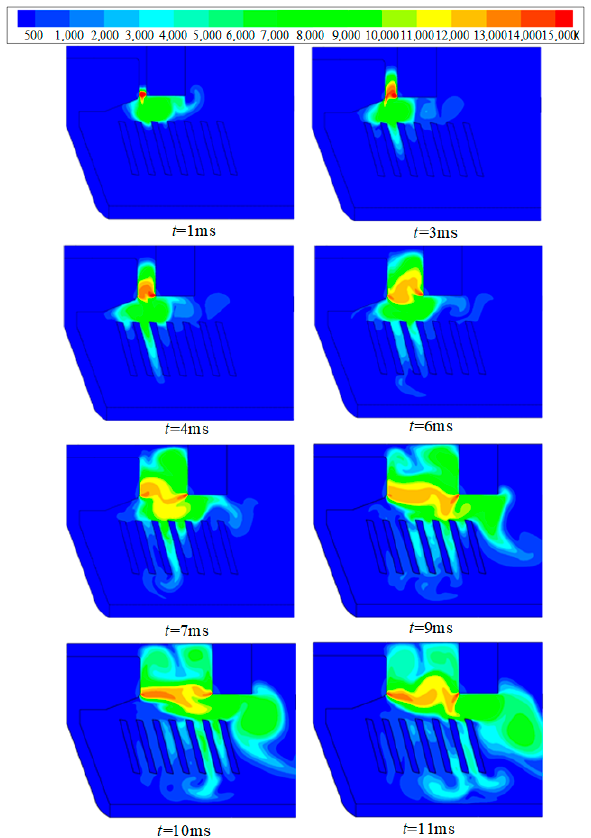
Figure 13. Temperature distribution of arc (DC 1500 V, I = 800 A).